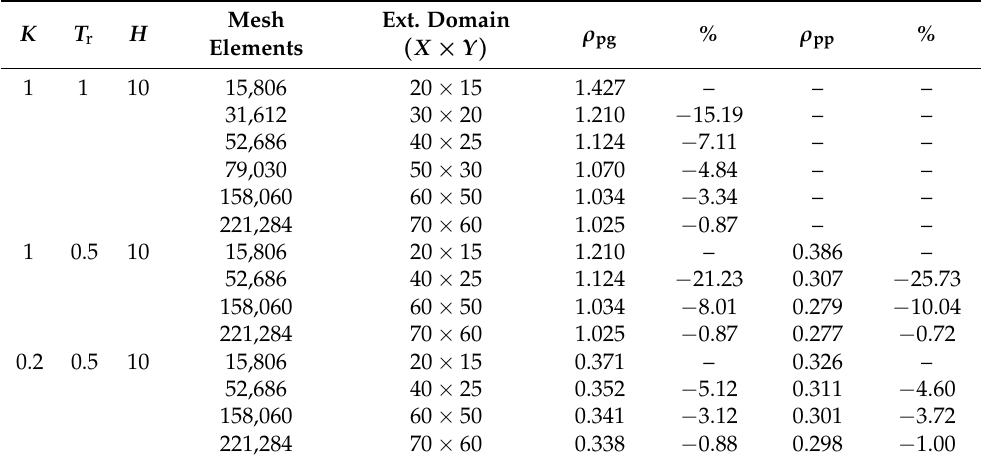
Table 1. Grid sensitivity analysis for W = 4, L = 1.3, H = 10, T r = 1 and 0.5, K = 1 and 0.2. K